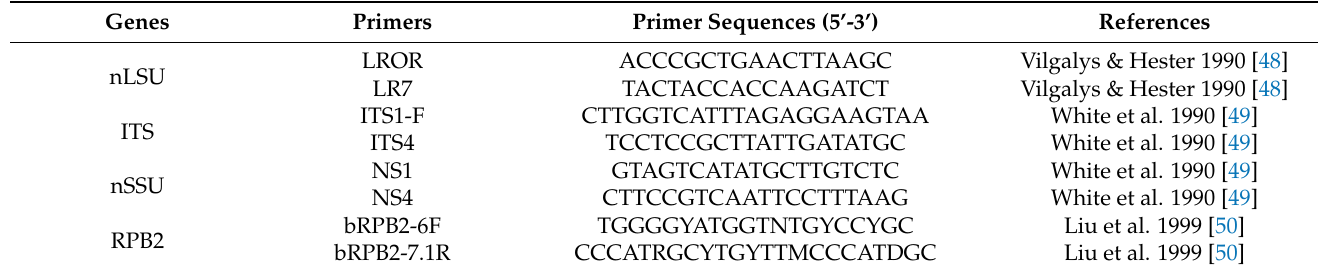
Table 2. The gene fragments, their corresponding primers and primer sequences used in this